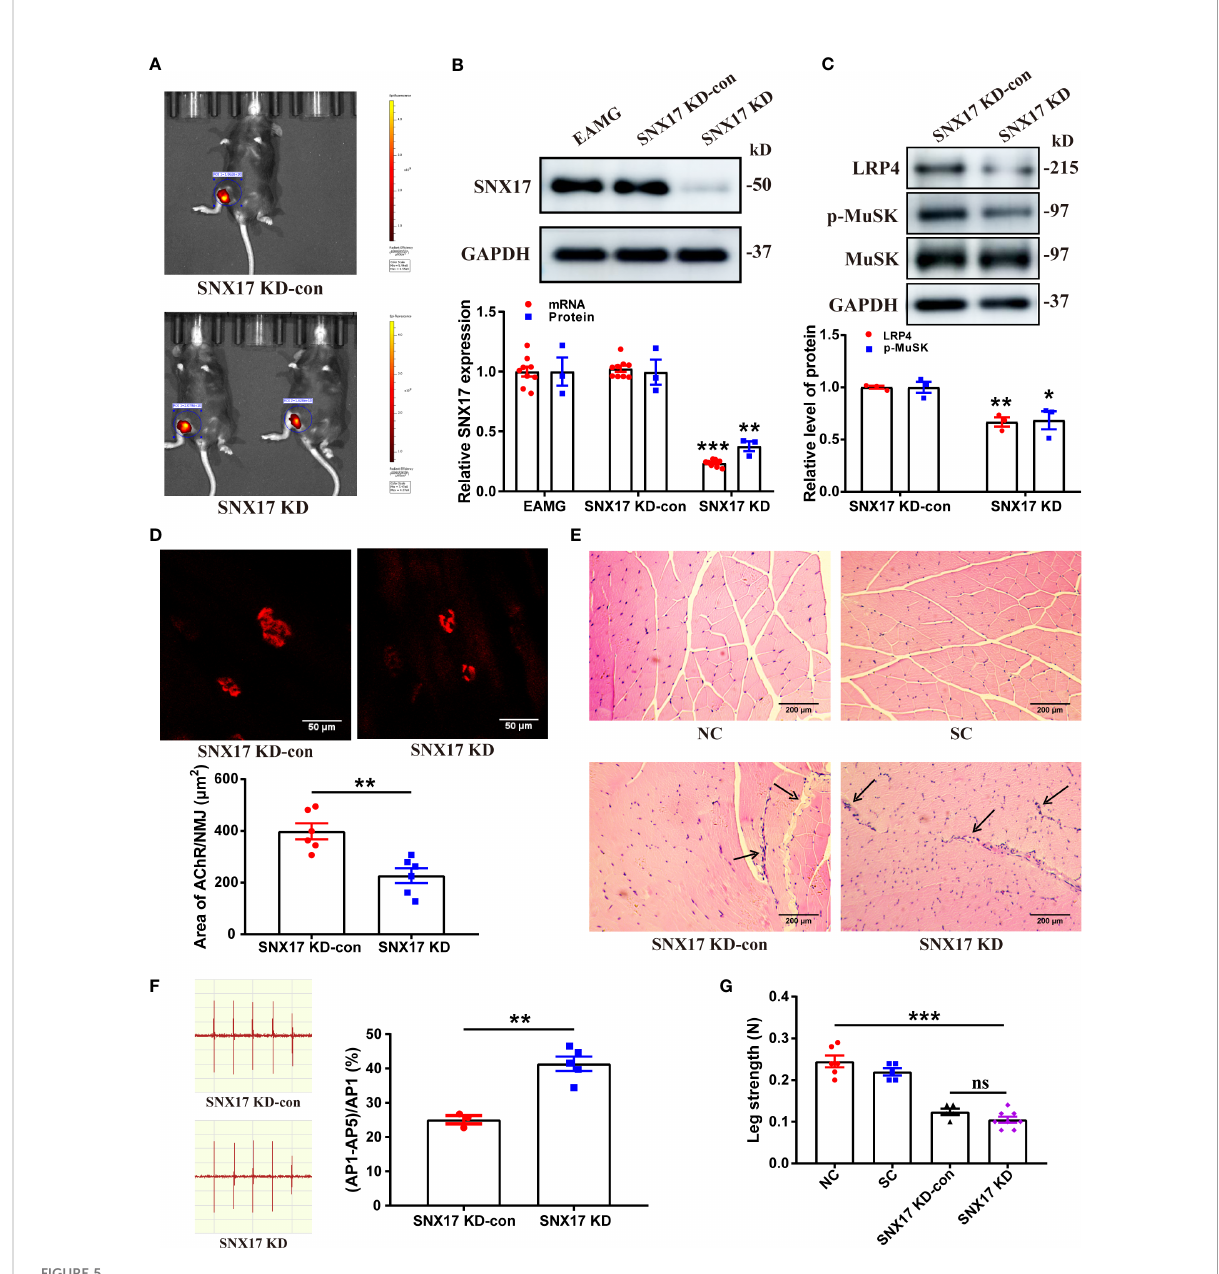
FIGURE 5 SNX17 knockdown decreased LRP4 expression and MuSK phosphorylation in the gastrocnemius muscle of EAMG mice and aggravated the degree of AChR fragmentation at the NMJ along with leg weakness. (A) Small-animal live imaging of EAMG mice infected with AAV2/9-EGFP NC and AAV2/9-m-SNX17 shRNA-EGFP for 21 days in the gastrocnemius muscle of the right leg. (B) Western blotting and qPCR analyses of SNX17 protein (n = 3/group) and mRNA (n = 9/group), respectively, in the mouse gastrocnemius muscle tissue. (C) Western blotting analyses of LRP4, MuSK, and p-MuSK levels in the mouse gastrocnemius muscle tissue. n = 3/group. (D) AChR (red) at the NMJ of the gastrocnemius fi laments was labeled with R-BTX and the area of AChRs was quanti fi ed with ImageJ. n = 6/group; Scale bar = 50 m m. (E) Hematoxylin and eosin – stained pathological analyses of cross-sections of the gastrocnemius muscle fi bers of mice in each group. Black arrows indicate muscle fi ber atrophy, rupture, or in fl ammatory cell in fi ltration. Scale bar = 200 m m. (F) EMG of the gastrocnemius muscle was measured using low- frequency RNS. The attenuation rate of the fi fth amplitude of EMG compared with the fi rst amplitude was calculated. SNX17 KD-con: n = 3; SNX17 KD: n = 5. (G) Bar dynamometer measurement of the right leg strength of mice in each group. NC: n = 6; SC: n = 5; SNX17 KD-con: n = 5; SNX17 KD: n = 8. All data are presented as mean ± SEM. * P <0.05, ** P <0.01, *** P <0.001. AChR, acetylcholine receptor; EAMG, experimental autoimmune myasthenia gravis; LRP4, low-density lipoprotein receptor-related protein 4; MuSK, muscle-speci fi c receptor tyrosine kinase; NC, normal control; NMJ, neuromuscular junction; R-BTX, rhodamine-labeled bungarotoxin; RNS, repetitive nerve stimulation; SC, solvent control; SEM, Standard Error of Mean; SNX17, sorting nexin 17. ns, no signi fi